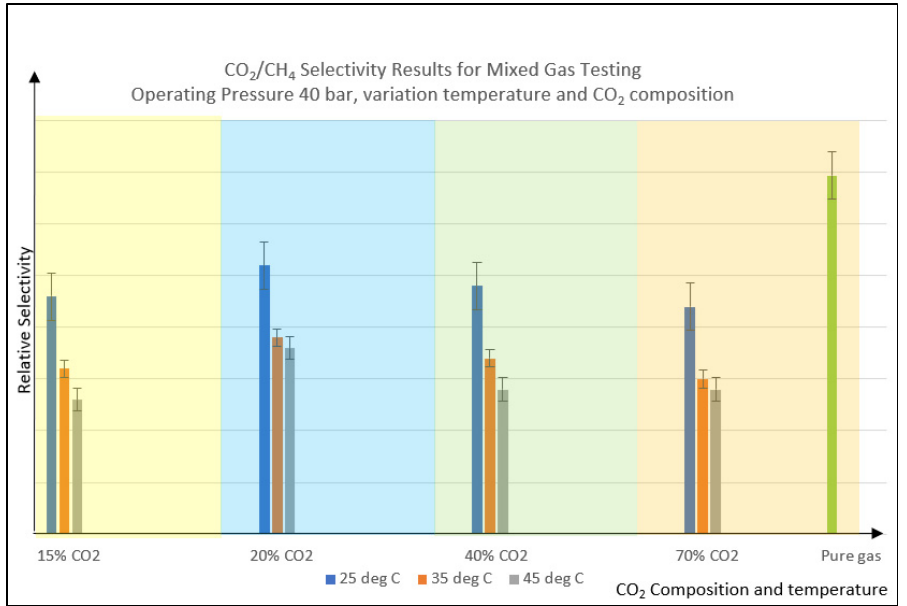
Figure 7. CO 2 /CH 4 selectivity result for mixed gas testing vs. variation of CO 2 composition and feed temperature. Note: Pure gas testing condition is 25 °C temperature with 3 to 7 barg applied pressure.